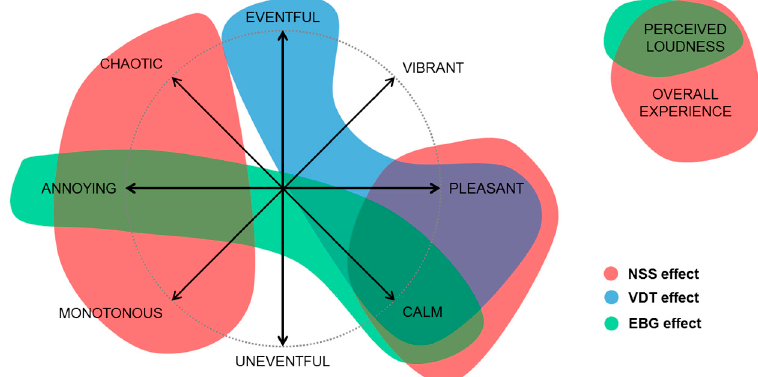
Figure 12. Schematic representation of the effects of personal factors (NSS, VDT and EBG variables) on Soundscape appraisal (depicted according to the “circumplex” model [37]), Perceived loudness and Overall experience.